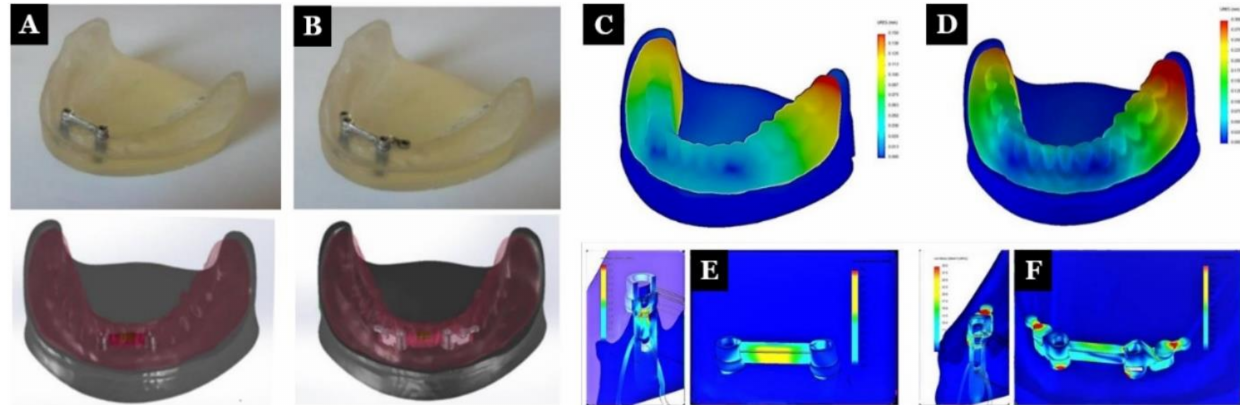
Figure 3. Real and computer models of the first studied system I ( A ) and the second studied system II ( B ). Distribution of displacements in an overdenture when an incisor was loaded with a vertical force of 50 N in system I ( C ) and system II ( D ). Distribution of stress within an implant and precision element when an incisor was loaded with a vertical force of 50 N in system I ( E ) and system II ( F )